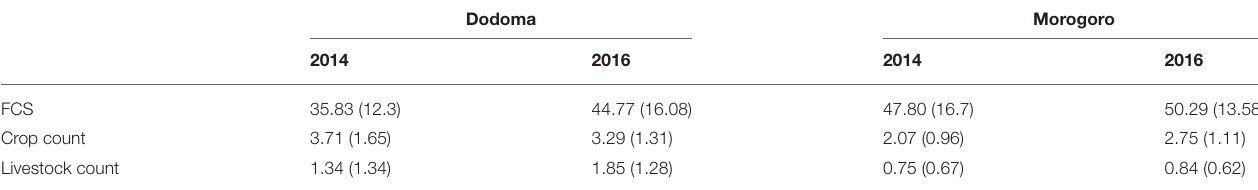
TABLE 2 | Descriptive statistics of dietary and production diversity variables disaggregated by